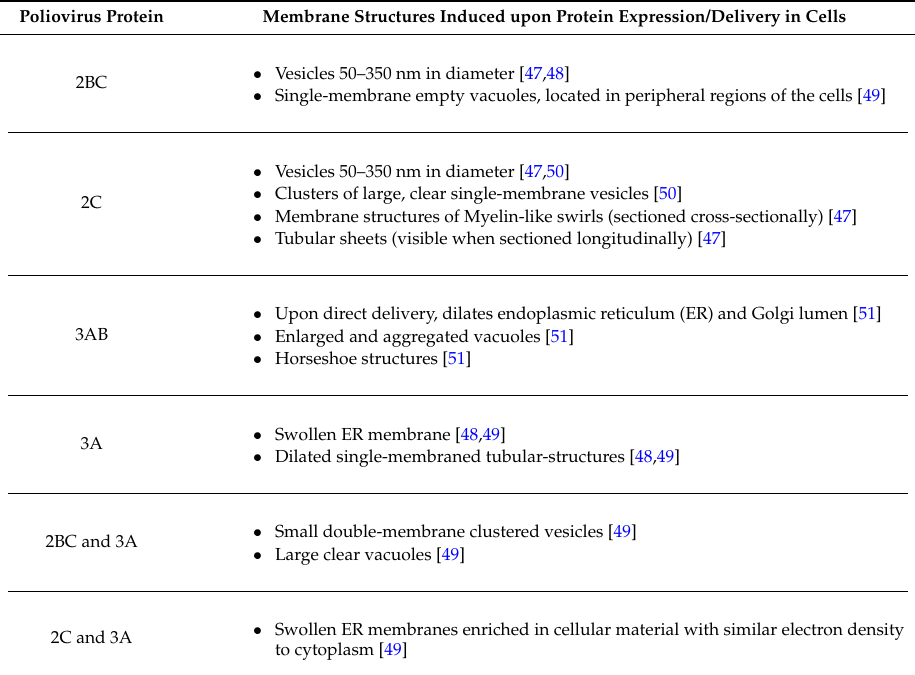
Table 2. Membrane remodeling induced by individual poliovirus proteins in the cell. Roles of individual poliovirus proteins in membrane